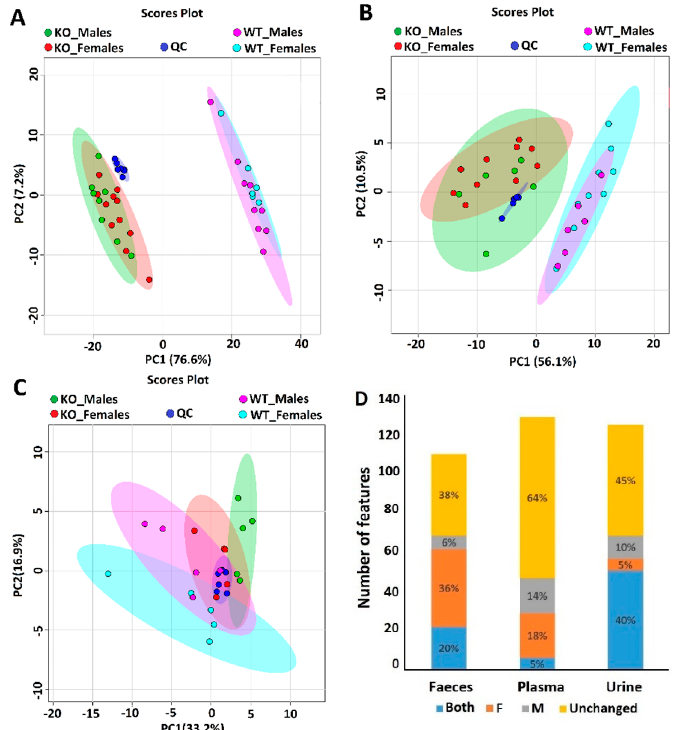
Figure 2. Principal component analysis of urine ( A ), faeces ( B ), and plasma ( C ) metabolome in SLC6A19ko and SLC6A19wt mice. Red data points represent ko females, green data points represent ko males, dark blue data points show quality control (QC) samples, light blue data points show wt females and pink data points wt males. Principal component analysis (PCA) separates the samples by genotype in urine ( A ) and faeces ( B ), but not in plasma ( C ). ( D ) Stack plot showing metabolic features that have different abundance in wt and ko mice regardless of gender as indicated by blue. Metabolic features that are unchanged are shown in yellow. Features only showing differences between wt and ko females are shown in orange, those that are different in males only are shown in grey. The y-axis shows the total number of metabolic features found in the samples.